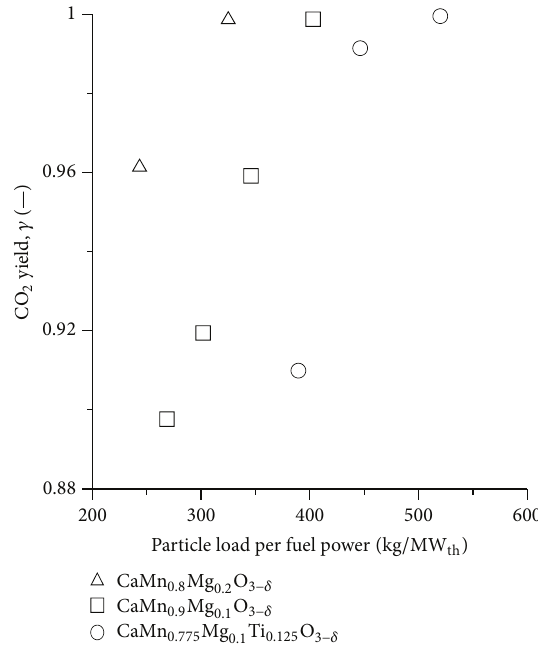
Figure 6: CO 2 yield as a function of solids inventory in FR per fuel power. The load was changed with the volumetric fuel flow (from 0.3 to 0.45 L N min −1 ) and it was assumed that 26% of the total inventory was located in the FR. Air flow was 6L N min −1 and temperature was 900 ∘ C. Each data point is an average of 15 minutes of